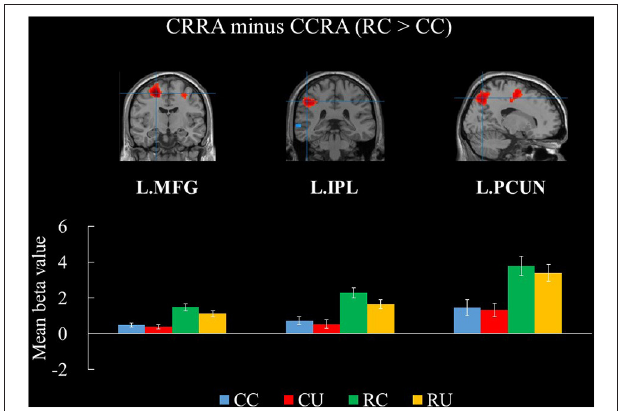
FIGURE 2 | Brain regions for the contrast between Chinese Compound and Radical Remote Associations. The bars show the mean beta values of the peak voxels for each of the four conditions. Error bars represent standard error of the mean. L, left; MFG, middle frontal gyrus; IPL, inferior parietal lobule; PCUN, precuneus; CCRA, Chinese Compound Remote Association; CRRA, Chinese Radical Remote Association; CC, Chinese Compound Remote Associates Test-Correct; CU, Chinese Compound Remote Associate Test-Unsolved; RC, Chinese Radical Remote Associate Test-Corrected; RU, Chinese Radical Remote Associate